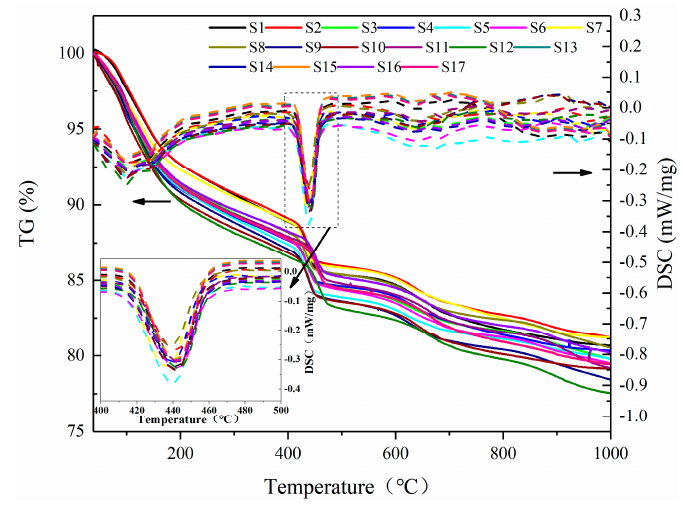
Figure 14. TG-DSC diagram of samples at 28 days.